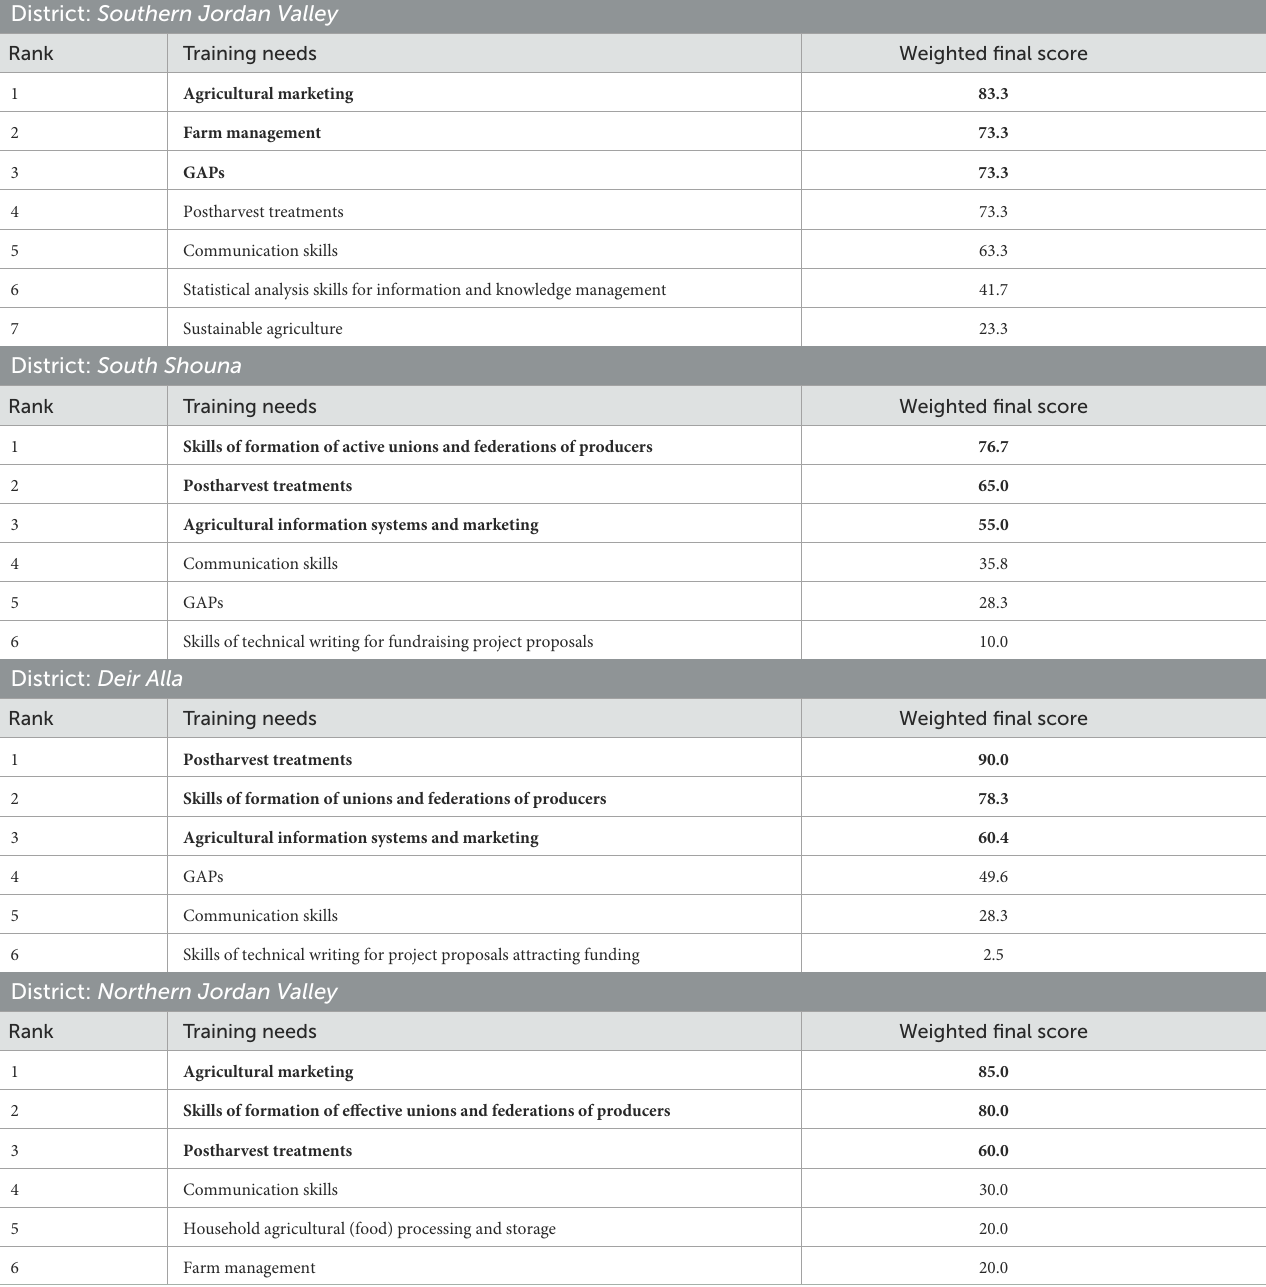
TABLE 4 The prioritized adaptive agribusiness training needs of the four investigated technicians and engineers focus groups demographic category from the Jordan Valley (sorted ascending; the top three training priorities for each group marked in bold in the far-right column). District: Southern Jordan